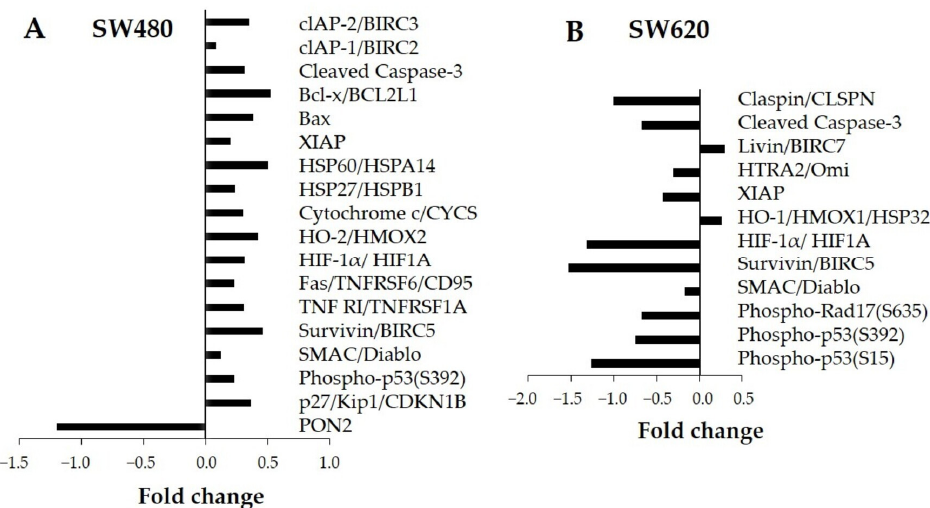
Figure 5. Evaluation of the effect of LMPE on modulation of apoptosis-related proteins. The protein fold changes for LMPE versus control in SW480 ( A ) and SW620 ( B ) cells. Cells were exposed to 30 mg LMPE/mL for 48 h. Untreated cells (0 mg LMPE/mL) were used as a control. Table 1. Biological processes and KEGG pathways after the STRING ® analysis of LMPE-modulated proteins for SW480 and SW620 cells. Analysis of protein interactions.